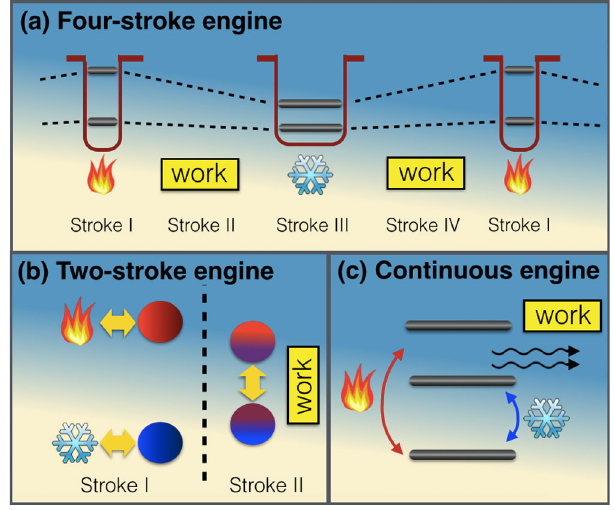
FIG. 1. (a) A two-level scheme of a four-stroke engine. (b) A two-particle scheme of a two-stroke engine. (c) A three-level scheme of a continuous